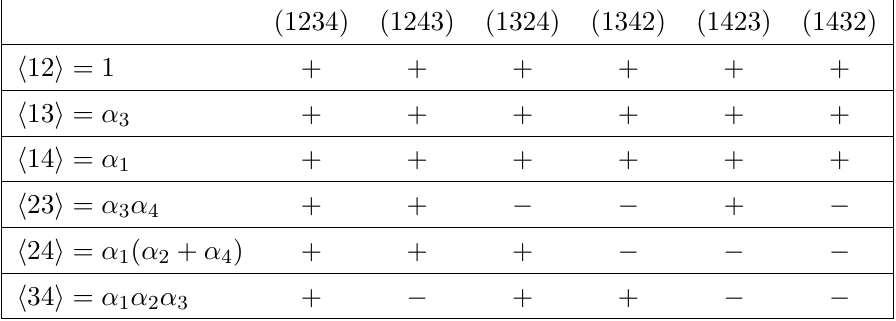
Table 1 . Positivity conditions coming from W ( σ )